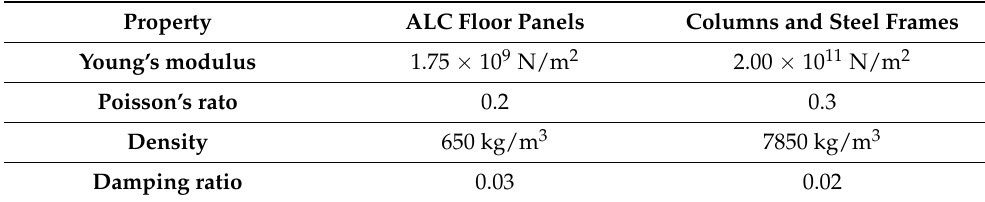
Figure 4. ( a ) Numerical model with beams and columns modeled using beam elements; ( b ) original view of structure illustrating thickness and cross-sectional shape of beams and columns. Table 1. Numerical parameters adopted in FEM